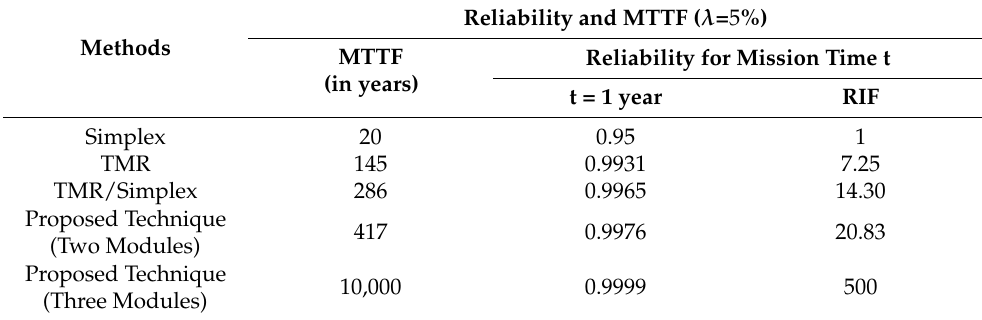
Table 2. Reliability and MTTF comparison.